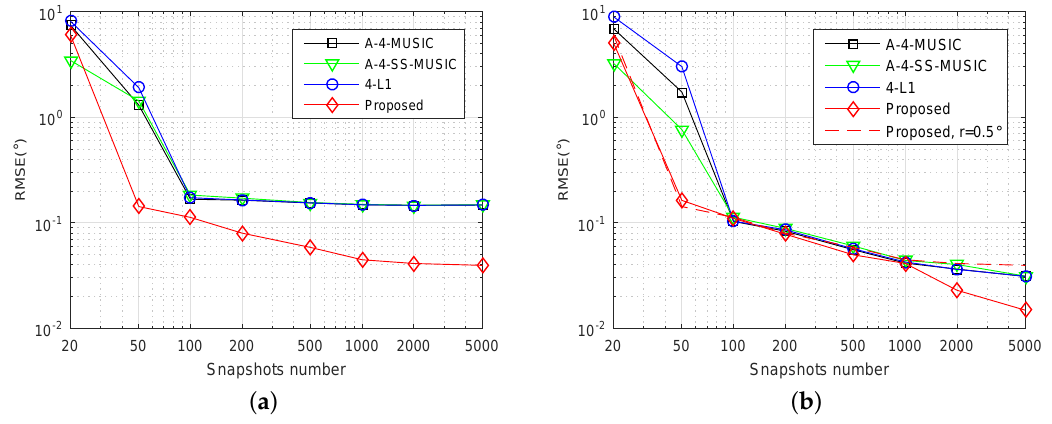
Figure 2. Root mean square error (RMSE) performance of four methods versus number of snapshots. S = { 1,2,4,11,25 } × d , K = 2, SNR = 3 dB, ( a ) r = 0.5 ◦ and ( b ) r = 0.1 ◦